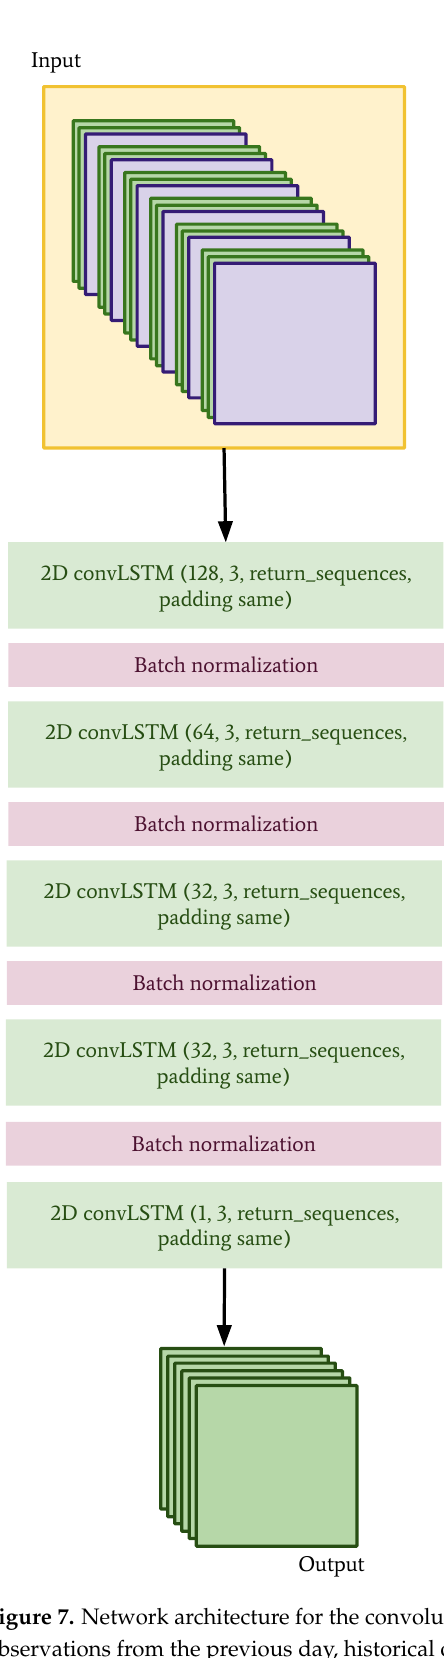
Figure 7. Network architecture for the convolutional LSTM. The input data are made up of historical observations from the previous day, historical observations from the 6 h prior to the predicted times, and NWP forecasts. These three inputs are treated like channels, such that the resulting dimensions of the input data are 6 × 40 × 40 ×